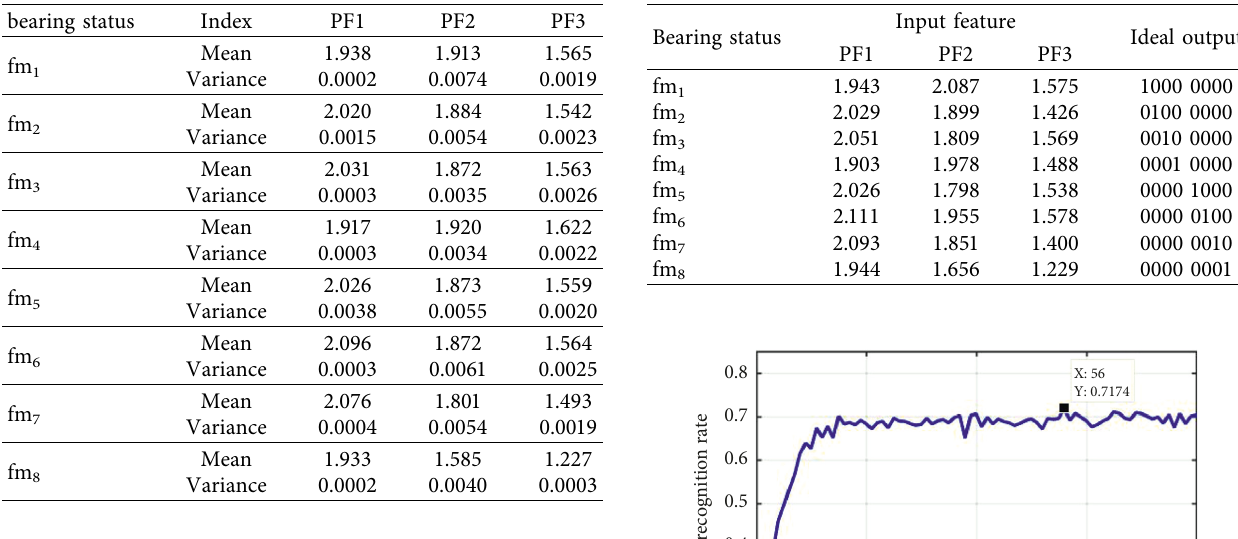
Table 4: Feature input and ideal output.